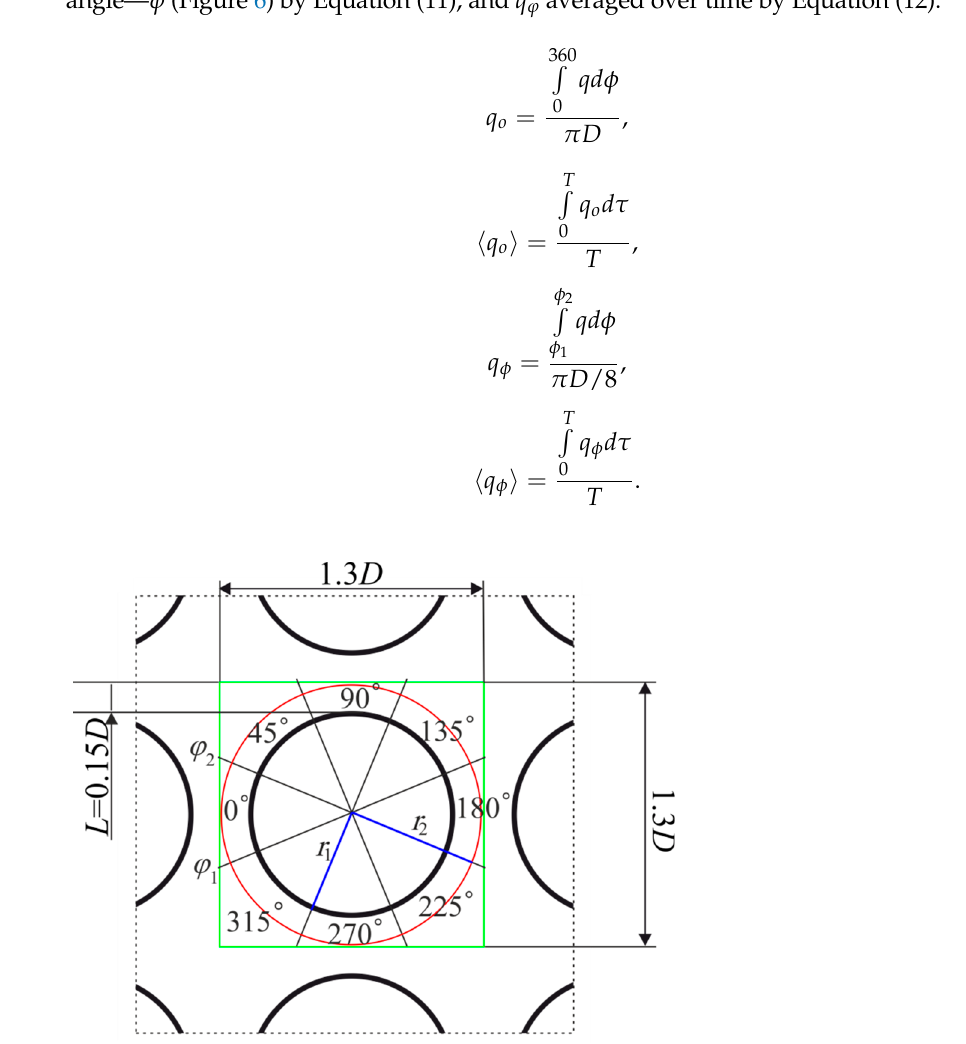
Figure 6. The location of the azimuth angle and the annular region around the cylinder of the fifth row of the tube bundle to determine the flow characteristics and heat